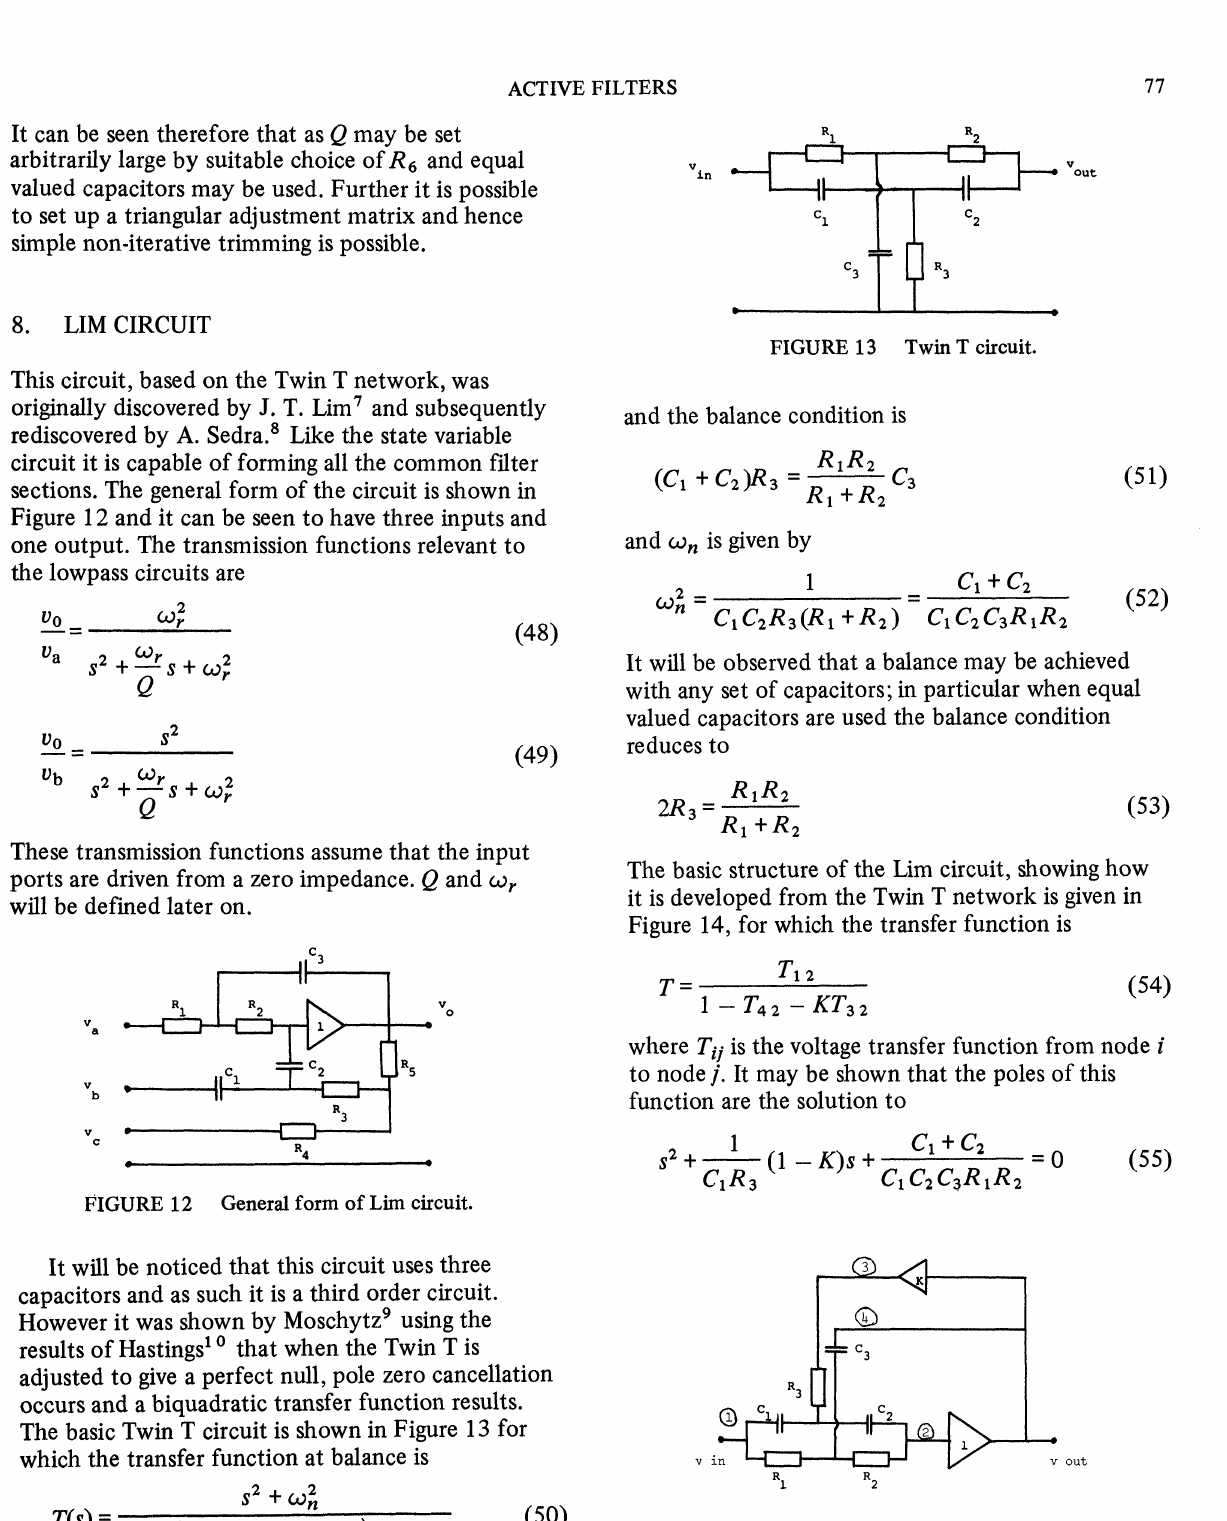
FIGURE 12 General form of Lira circuit.